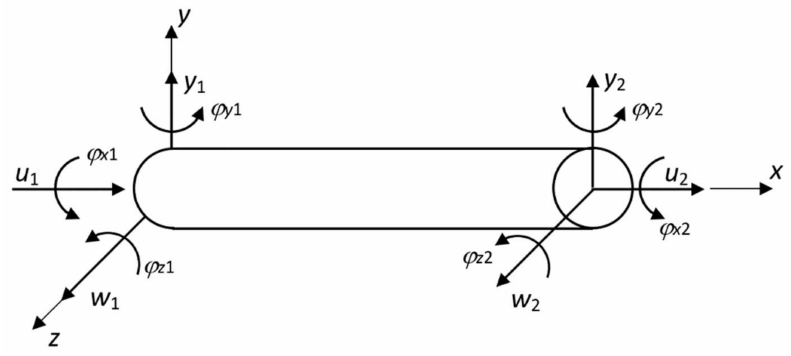
Figure 2. The two-node finite element of the rod in three